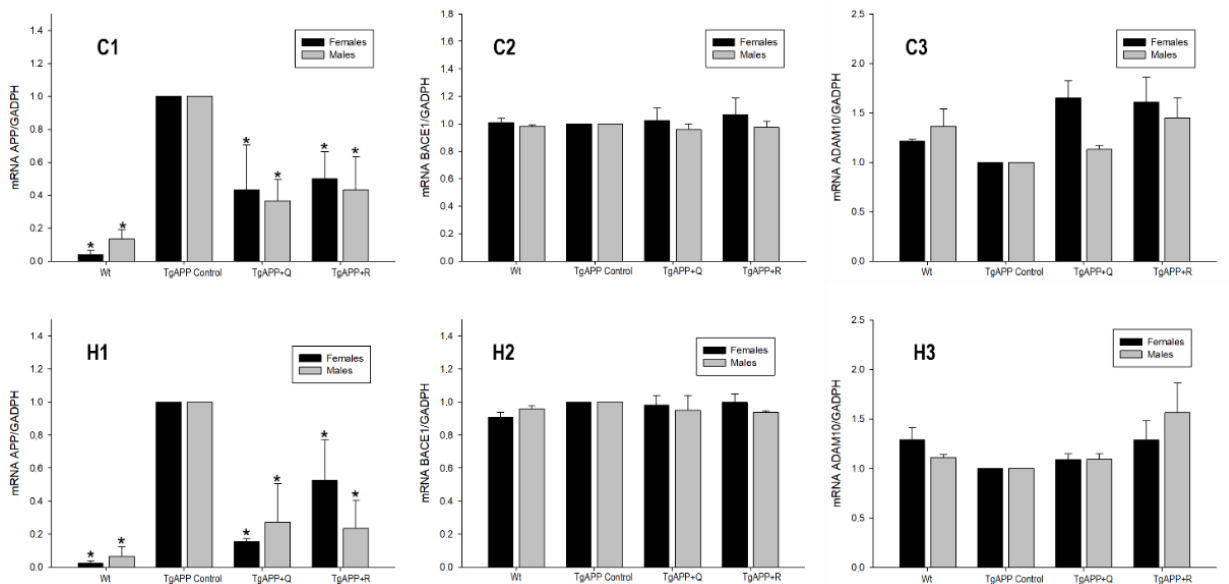
Figure 7. Effect of quercetin (Q) and rutin (R) on APP (C1, H1), BACE1 (C2, H2), and ADAM10 (C3, H3) expression in the Cortex (C) and the Hippocampus (H). (1) WT; (2) TgAPP control; (3) TgAPP + Q; (4) TgAPP + R. * p < 0.05 vs. TgAPP control (ANOVA followed by the post-hoc Newman–Keuls multiple comparison test).